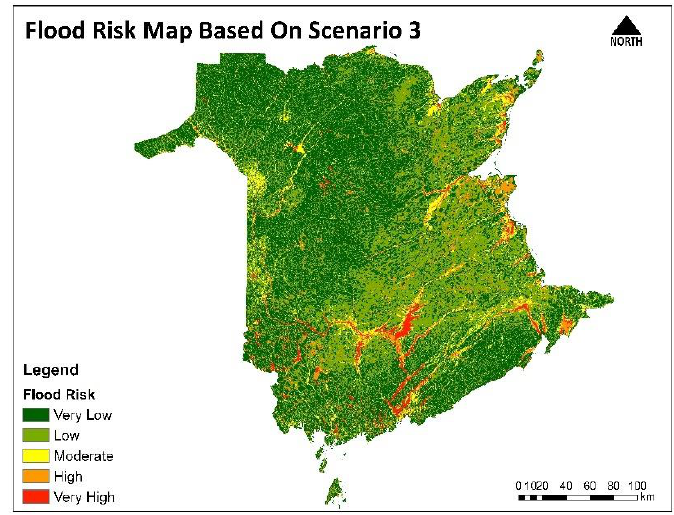
Geosciences 2020 , 10 , x FOR PEER REVIEW Figure A18. Flood Risk Map Based on Scenario 2. Figure A18. Flood Risk Map Based on Scenario 2.